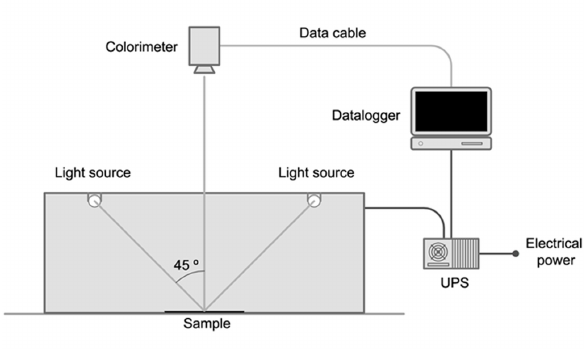
Figure 5: Laboratory